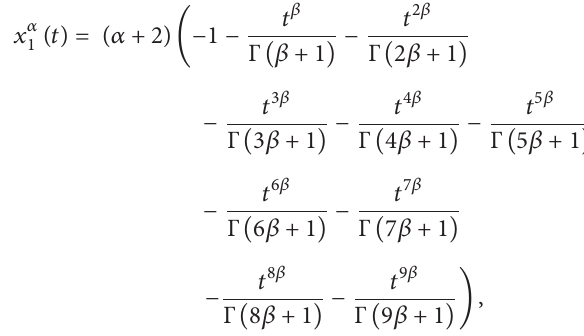
Figure 1: The numerical solution of (36) for (a) 𝛽 = 0.6 , (b) 𝛽 = 0.8 , and (c) 𝛽 = 1